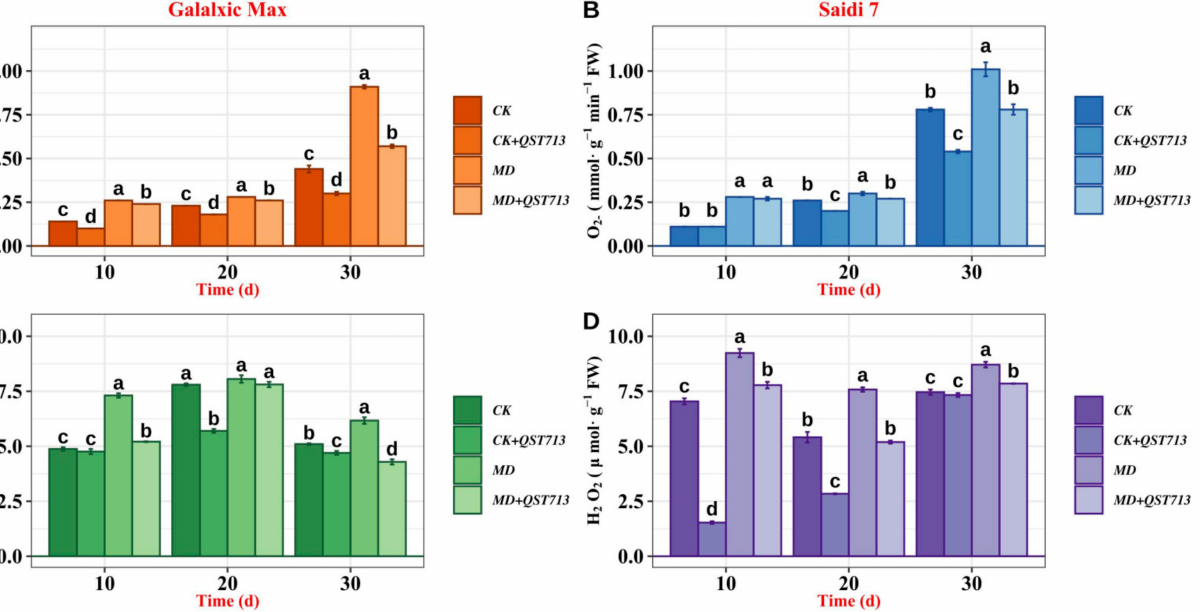
Figure 4. Effect of drought stress and QST713 application on the content of O 2 . − ( A , B ) and H 2 O 2 ( C , D ) of alfalfa seedlings in two cultivars (( A , C ), Galalxic Max; ( B , D ), Saidi 7). Data are the mean ± SE ( n = 3). Different letters indicate significant differences from each other ( p < 0.05).